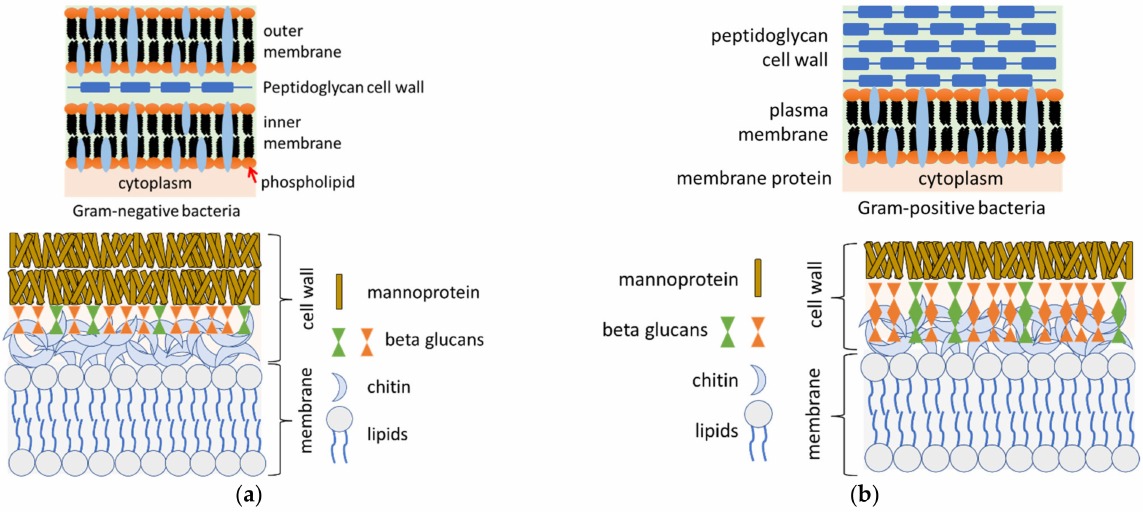
Figure 2. Illustration of the structure of the cell walls of Gram negative bacteria, Gram positive bacteria, and fungal cell walls showing ( a ) hyphae cell wall and ( b ) yeast cell